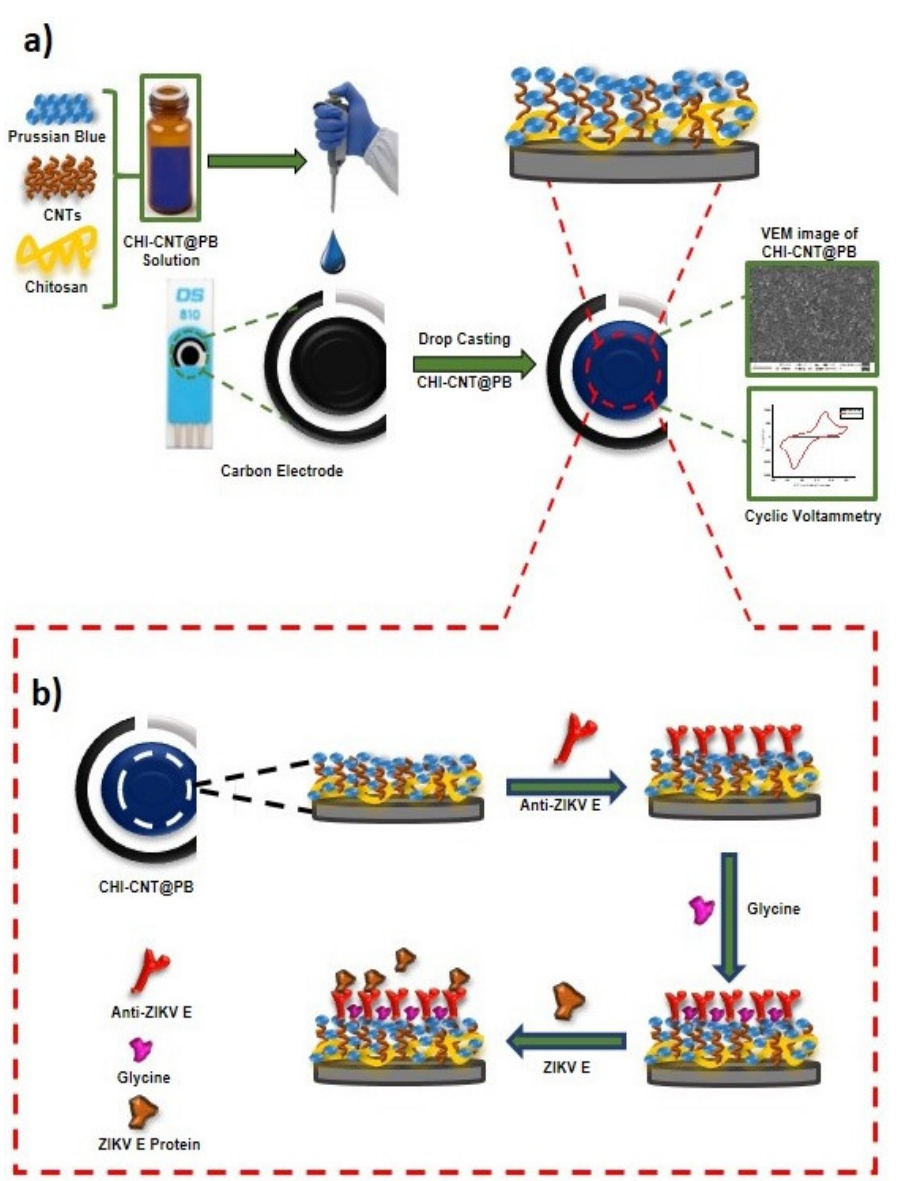
Figure 1. Diagram of the ZIKV immunosensor: ( a ) steps performed in the synthesis of the nanostructured electrode and ( b ) process of immobilization of the anti-ZIKV E protein and immu-